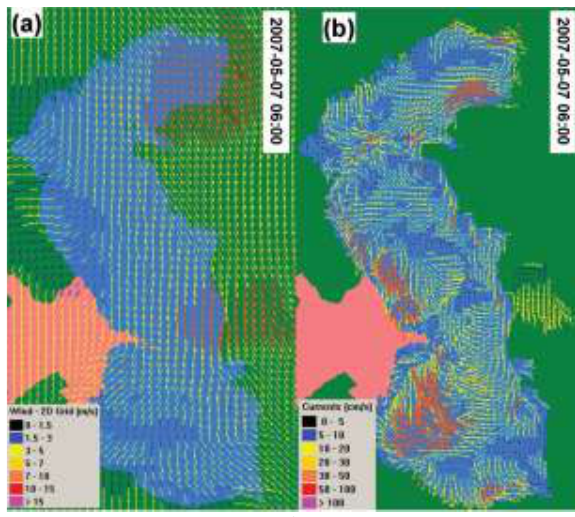
Figure 4. Example snapshots of Caspian sea winds and currents visualized in OSCAR for date and time of 2007-05-07 06:00